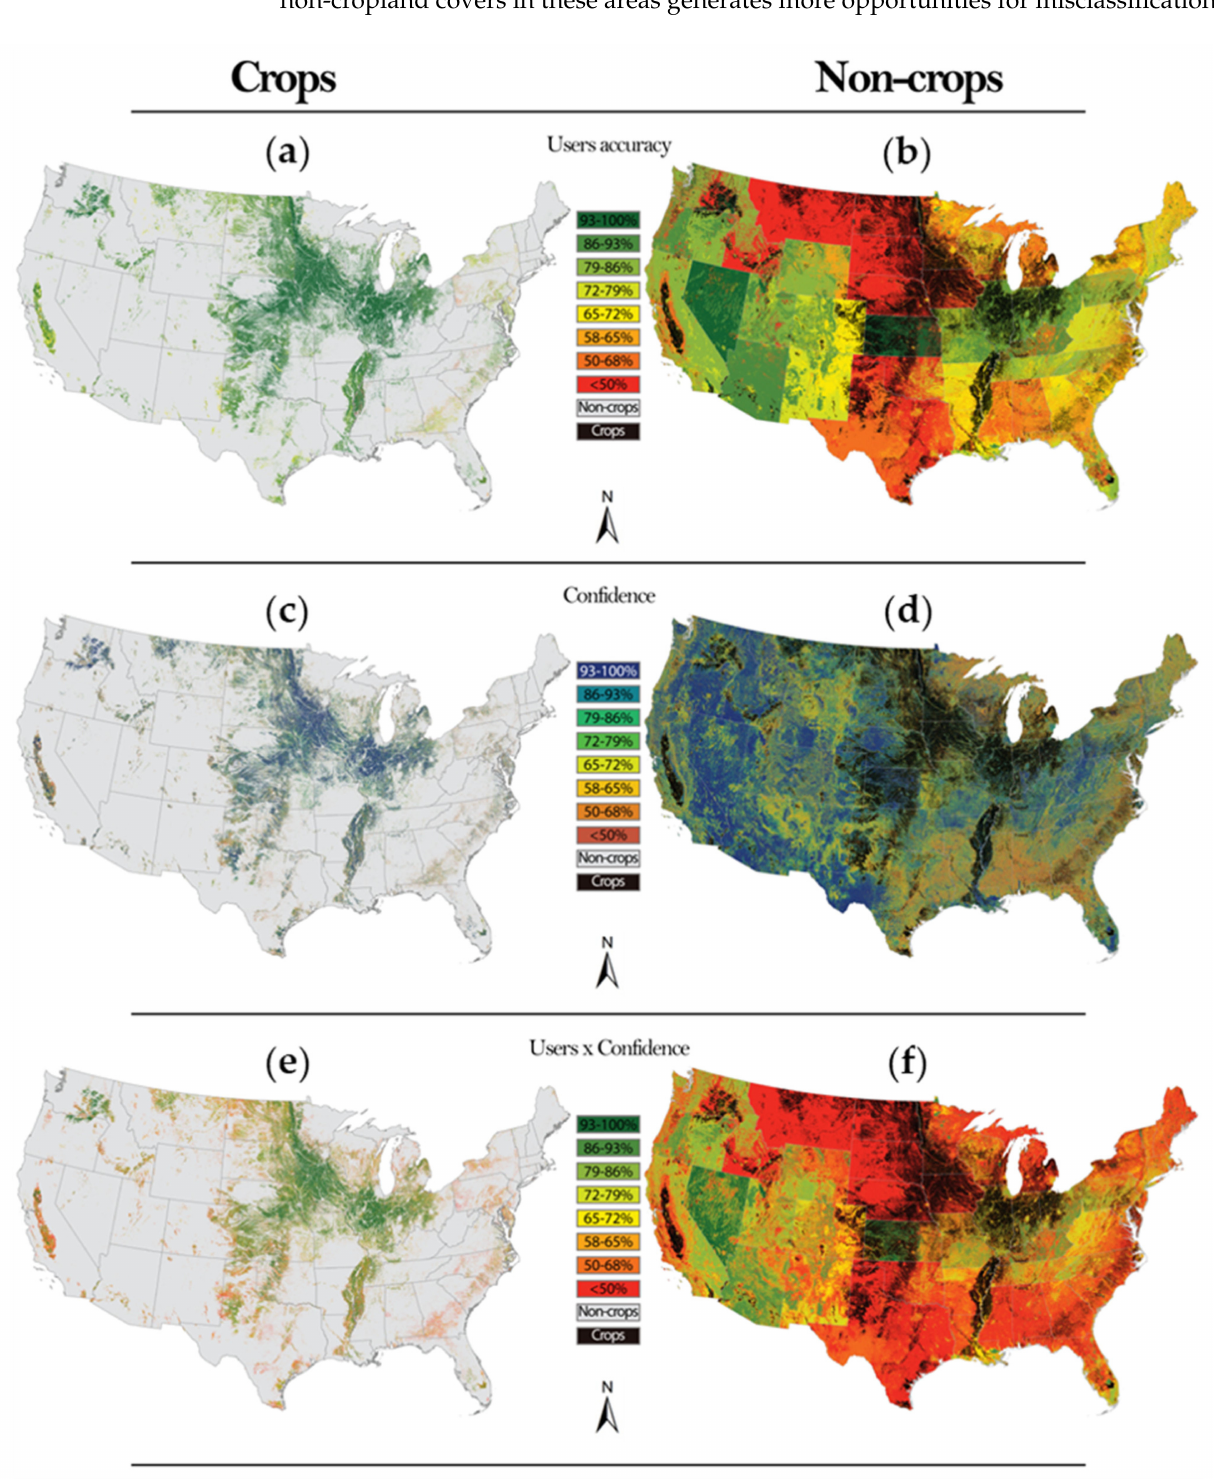
Figure 2. Panel of the user’s accuracy ( a,b ), confidence layer ( c , d ), and combined product of user’s accuracy and confidence layer ( e , f ) delineated for crop ( a , c , e ) and non-crop ( b , d , f ) classes of the CDL for